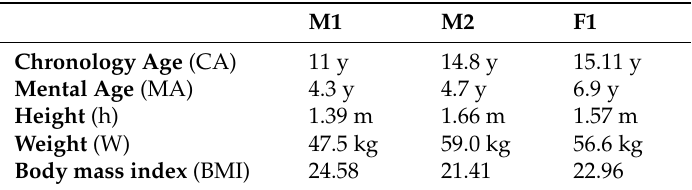
Table 1. Characteristics of the